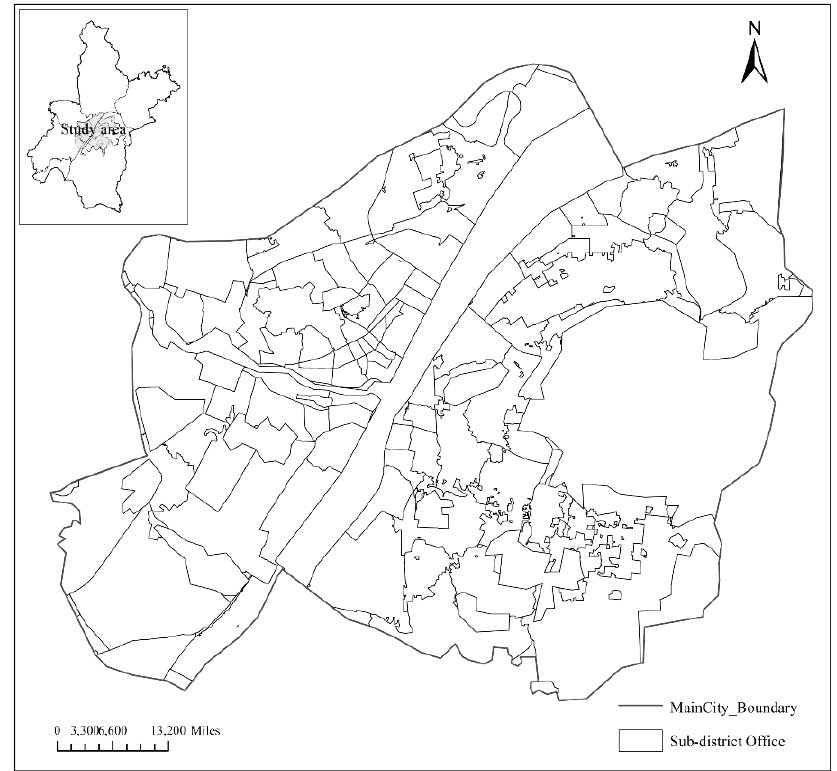
Figure 3. Study area in Wuhan.